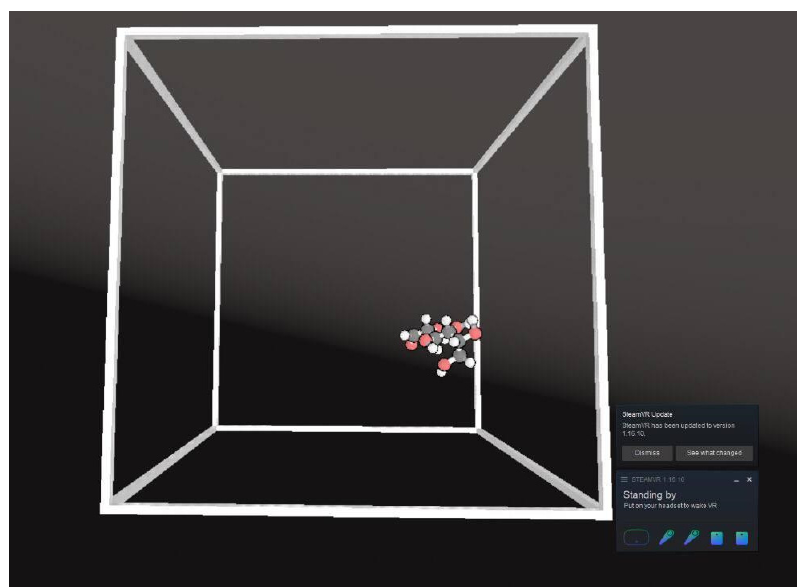
Figure 5. An example of the VR environment in NarupaXR showing d-glucose molecule.